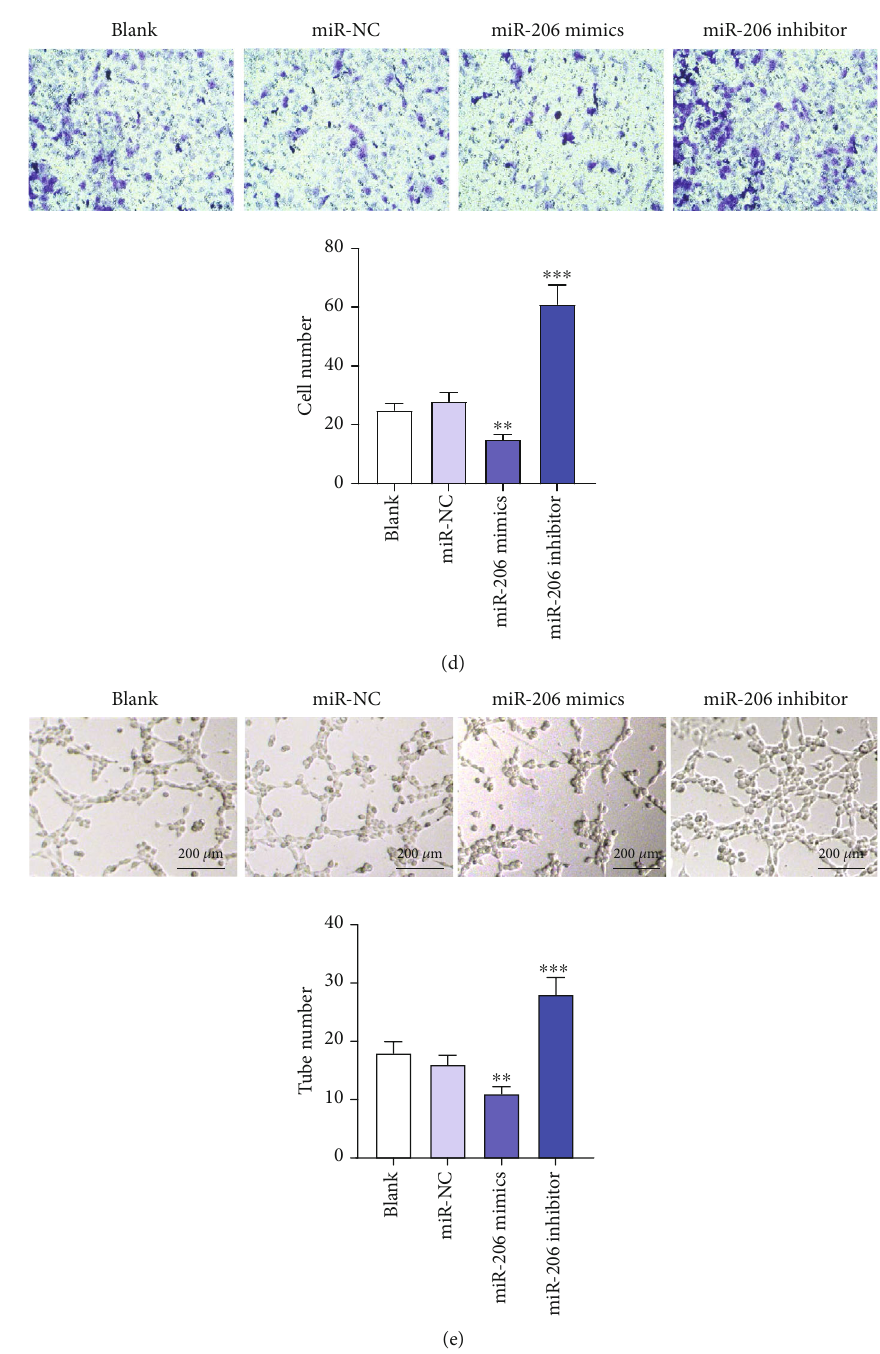
Figure 1: The in fl uence of miR-206 on EPC proliferation, apoptosis, migration, and angiogenesis. (a) PCR analysis of miR-206 expression in EPCs after transfection with miR-NC, miR-206 mimics, or miR-206 inhibitor. (b) CCK-8 assay of EPC proliferation after the above transfection. (c) Flow cytometry analysis of the apoptosis of EPCs after the above transfection. (d) Transwell assay of the migration of EPCs after the above transfection. Representative images of cell migration and the number of migratory cells are shown. (e) In vitro tube formation assay of the angiogenesis of EPCs after the above transfection. Representative images of capillary tube formation and the number of tubes are shown. ∗∗ p < 0 : 01 and ∗∗∗ p < 0 : 001